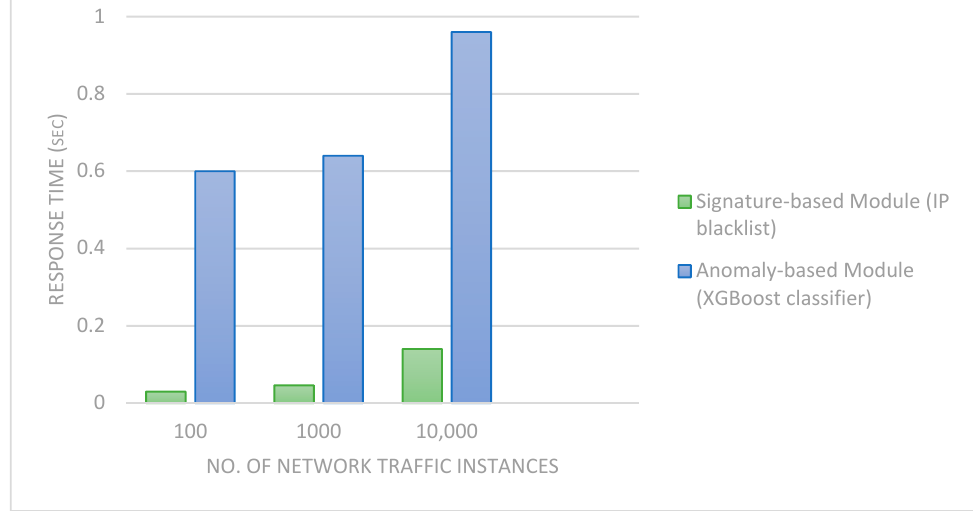
Figure 7. Response time of the signature-based and anomaly-based modules.